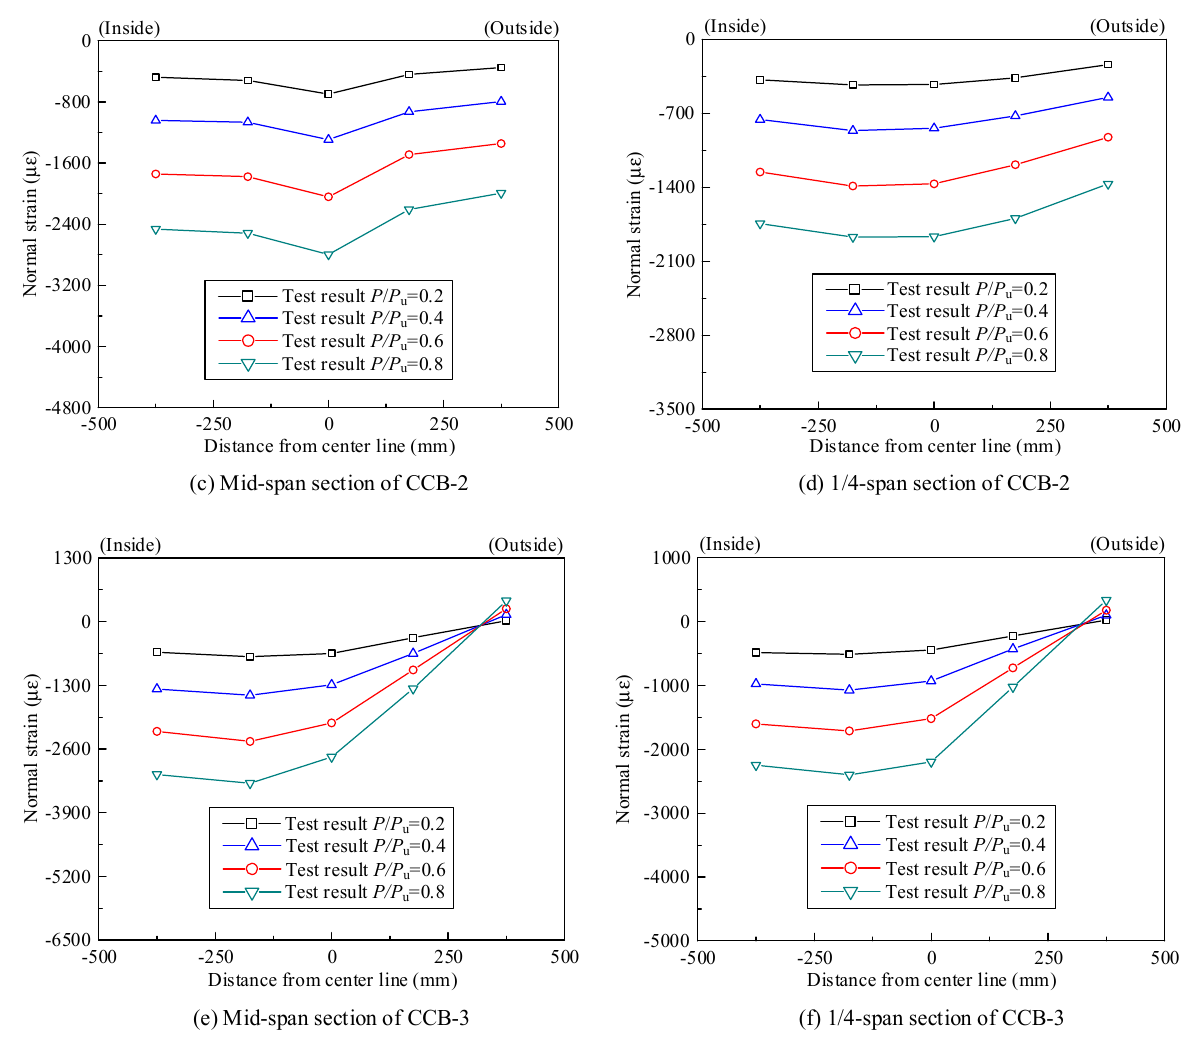
Figure 11. Normal strain distribution of the concrete slab or rebar of the test specimens. Figure 12 shows the normal strain distribution of the steel bottom flange of CCB-1 at the midspan section and the 1/4-span section. The key areas of the midspan sections of CCB-1–CCB-3 reached yield strains at 0.6 P u , 0.8 P u , and 0.6 P u , respectively. The key areas of the 1/4-span sections of CCB-1 and CCB-3 reached yield strains at 0.8 P u and 0.8 P u , respectively, and the 1/4-span section of CCB-2 was in the elastic stage. The trends of and differences in the strain distributions of the steel bottom flanges of each specimen were basically consistent with those of the concrete slab.